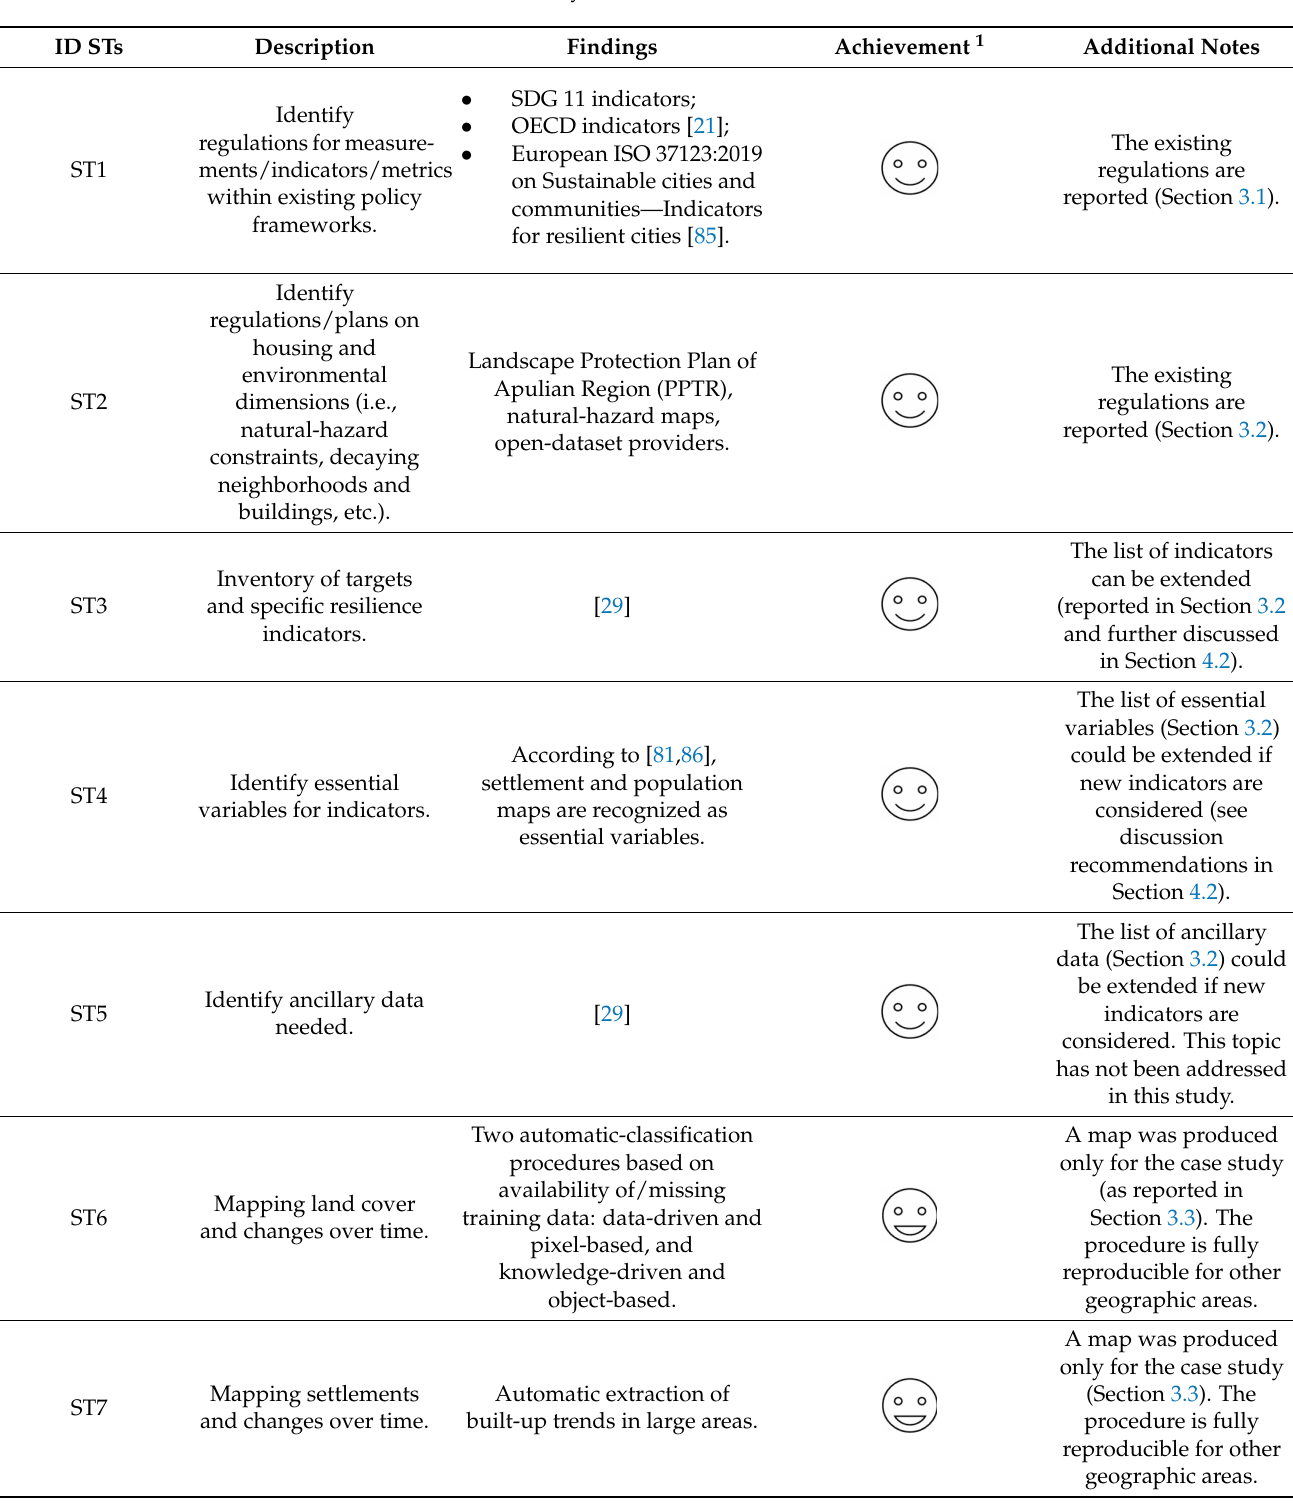
Table 8. Assessment analysis of SMIG2